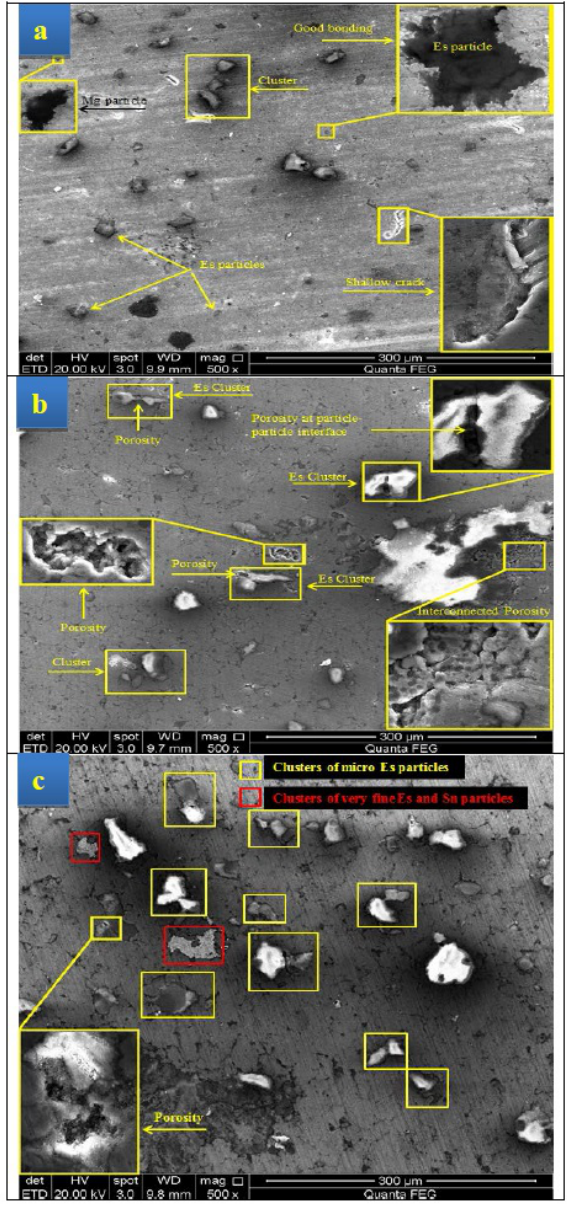
Figure 10: (a) SEM image of Al-1.5Mg-1.5Sn-3Es composite show- ing uniform distribution of particles and good bonding at matrix- particle interface, (b) SEM image of Al-1.5Mg-1.5Sn-6Es composite showing higher number of clusters accompanied with porosity at particle-particle interface and (c) SEM micrograph of Al-1.5Mg- 1.5Sn-9Es composite showing the highest number of clusters which accompanied with porosity at particle-particle interface.